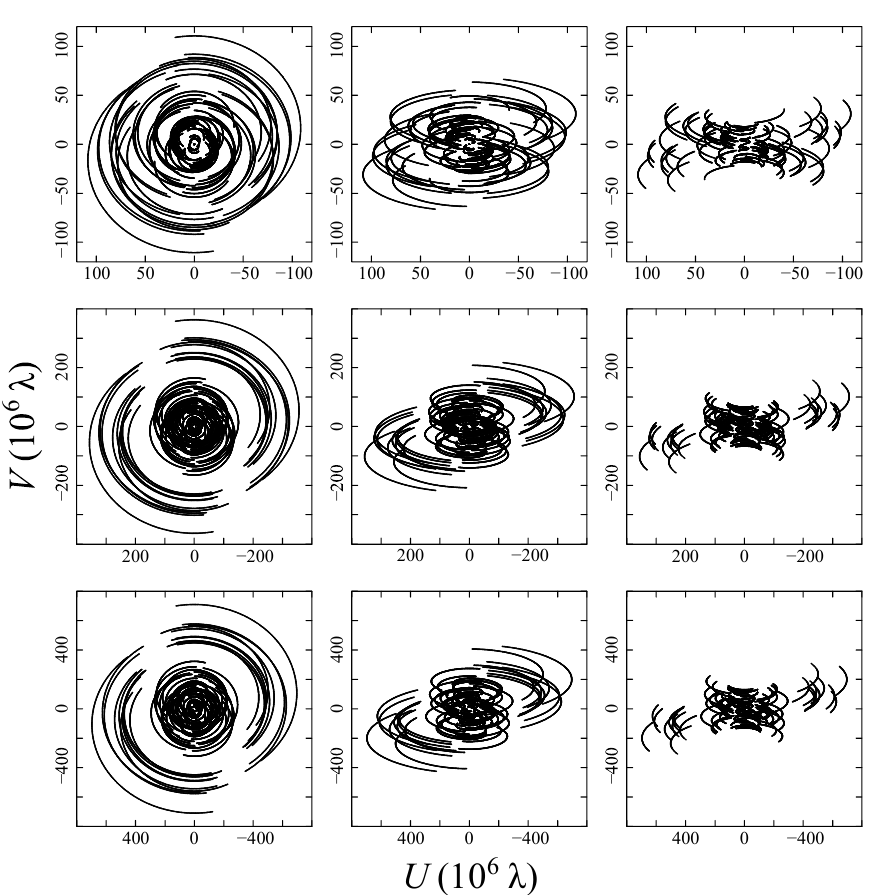
Figure 2. Examples of the ( u , v ) coverage for an EAVN observation with full array configuration at 6.7 (upper panels), 22 (middle panels), and 43 GHz (lower panels) with the source’s declination of + 60 ◦ (left panels), + 20 ◦ (center panels), and − 20 ◦ (right panels). λ represents the observing wavelength. Total observing duration of 10 h and the antenna’s lower elevation limit of 15 ◦ are assumed for all